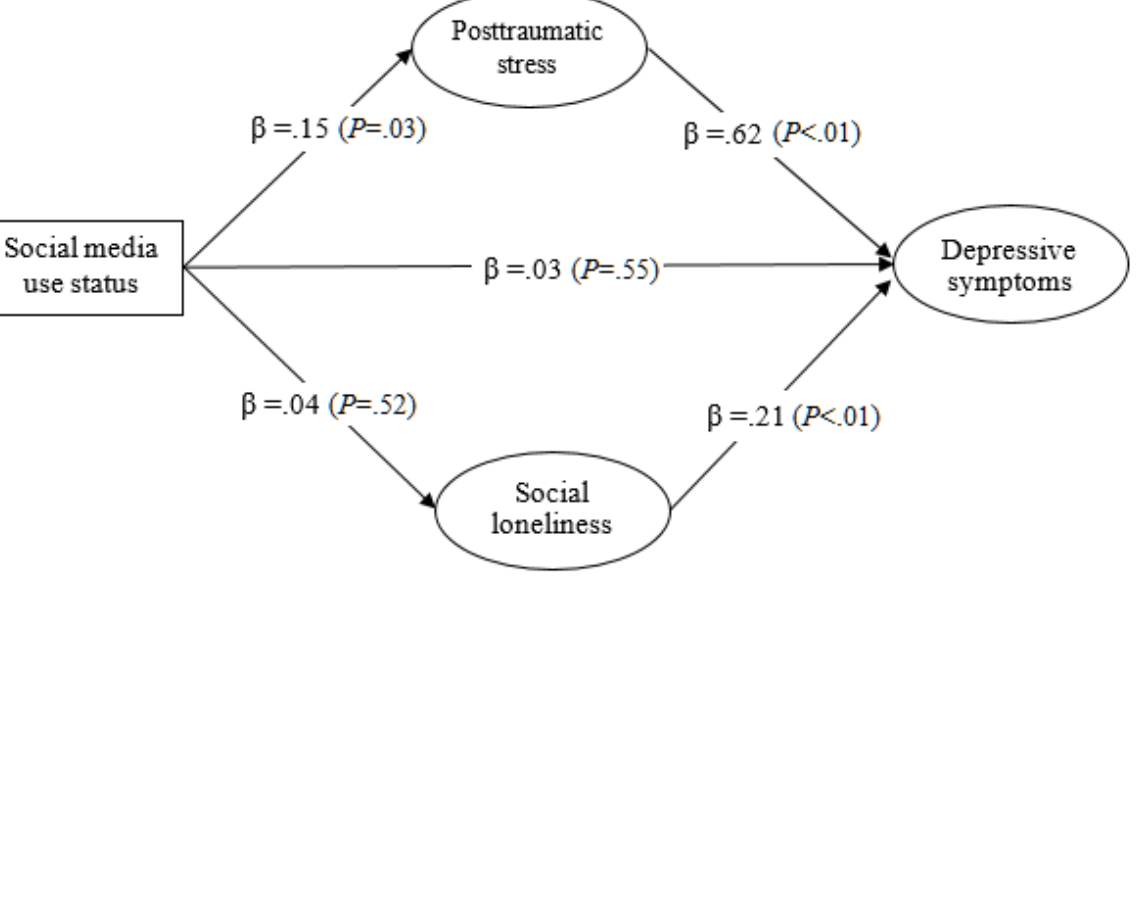
Figure 1. The proposed mediation model of depressive symptoms with standardized regression coefficients ( β ) among younger adults in Hong Kong during the COVID-19 pandemic